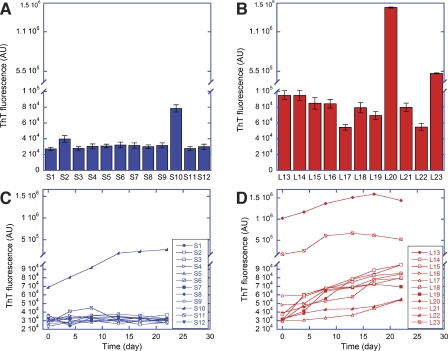
Thio T Binding of GnRH Analogs Indicative of Amyloid Fibril FormationThio T fluorescence of (A) short-acting and (B) long-acting analogs listed in Tables 1, S1, and S2 after 21 d of incubation at room temperature without stirring. Kinetics of fibril formation of (C) short-acting and (D) long-acting GnRH analogs. The intensity of Thio T fluorescence is shown as arbitrary units (AU). The error bars represent the standard deviation of three independent experiments.